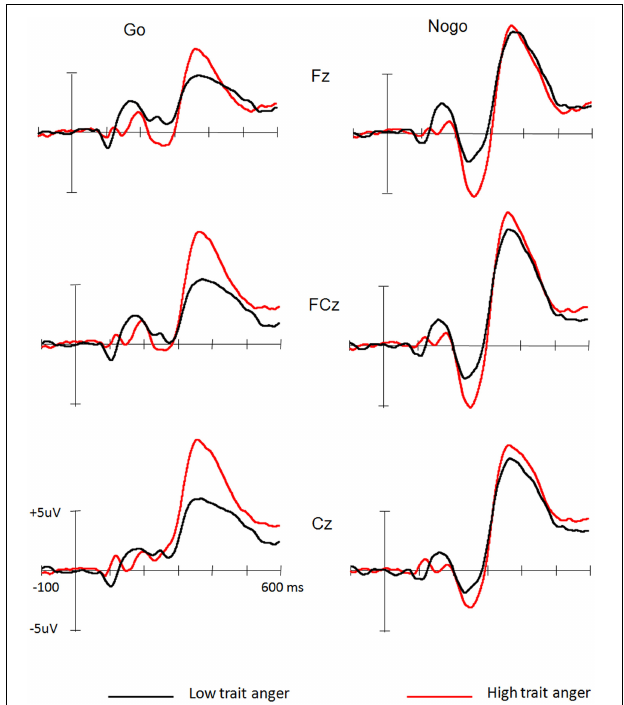
FIGURE 1 | Grand average waveforms elicited by Go and Nogo stimuli in low and high trait anger groups, respectively.